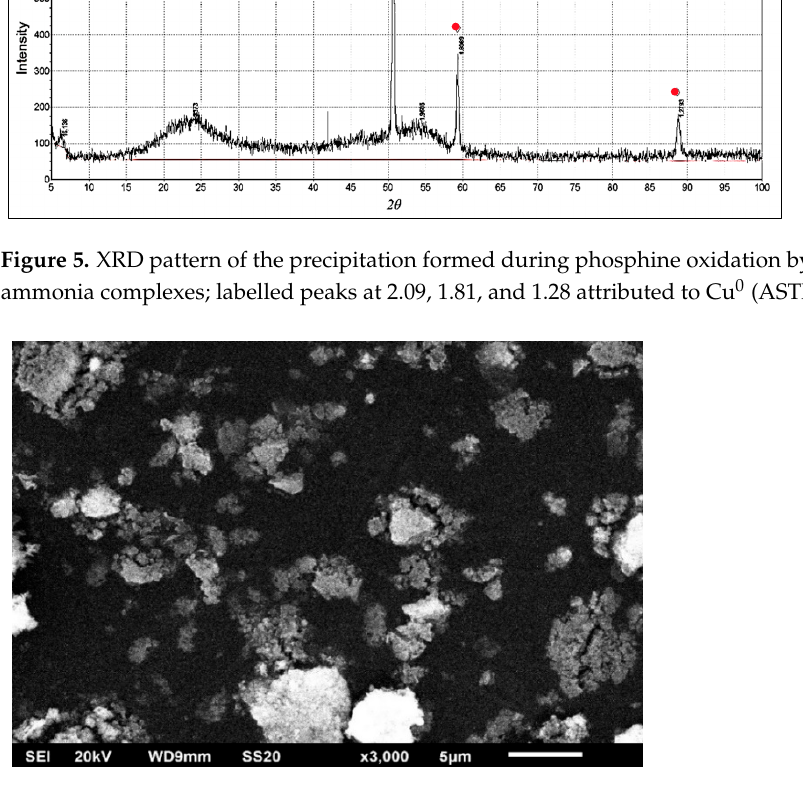
Figure 6. SEM pattern of Cu 0 -containing precipitation.